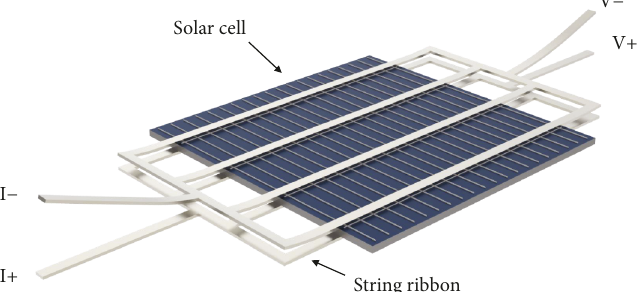
Figure 3: Schematic of the connect mode of the I – V tester to the cells soldered with interconnection